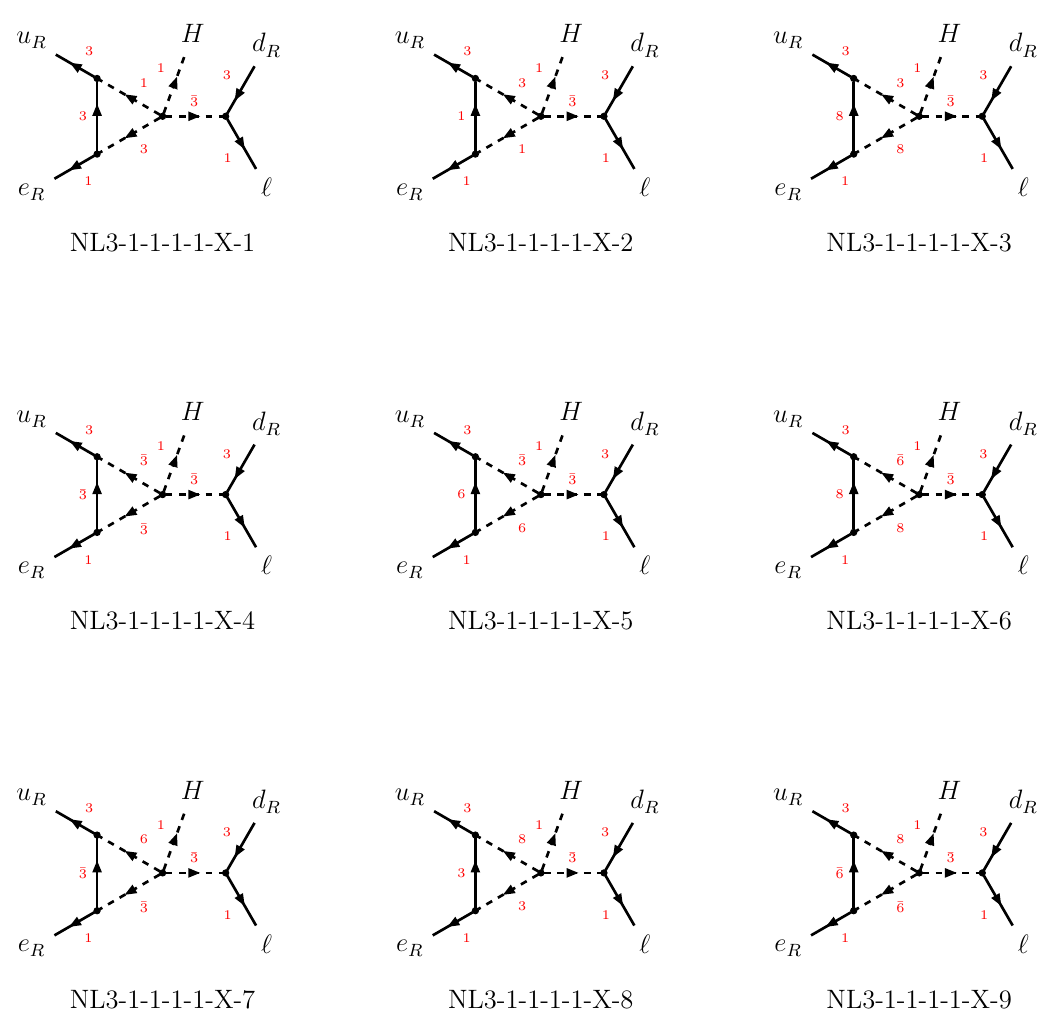
Figure 10 . Assignments of the SU(3) X=1, 2, 3 stands for the possible SU(2)